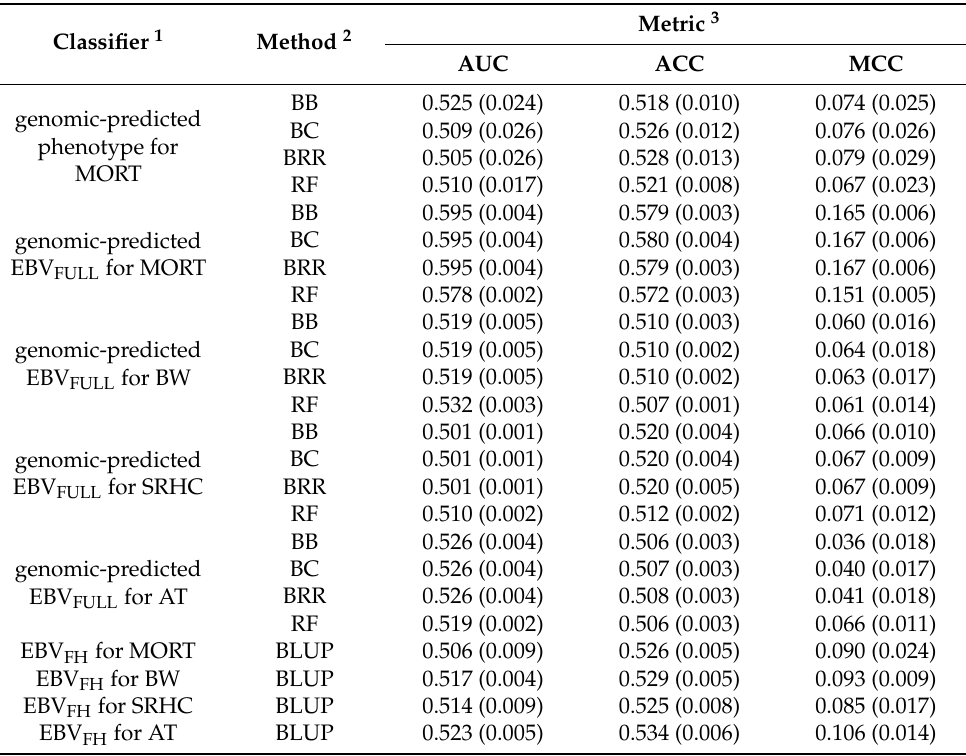
Table 2. Average metrics (SD) of classification performance for different classifiers of VNN mortality in 16 independent five-fold